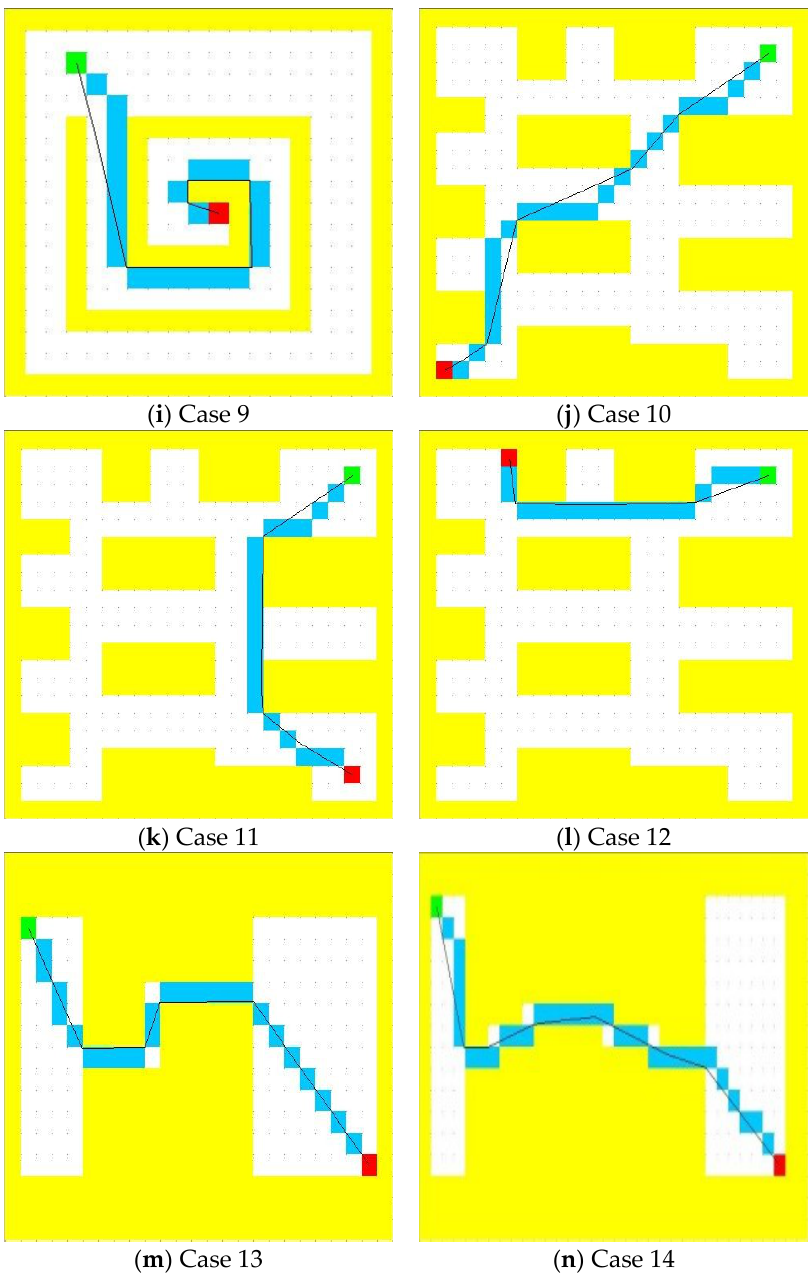
Figure 3. Path planning in distinct maps.